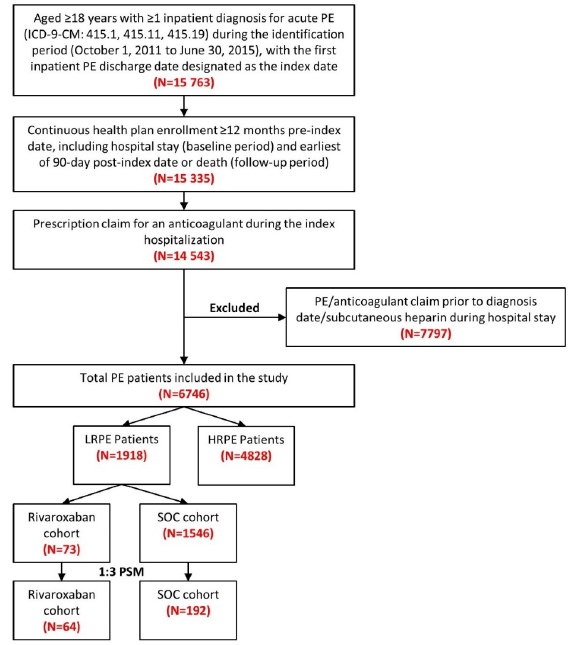
Figure 1. Study Design